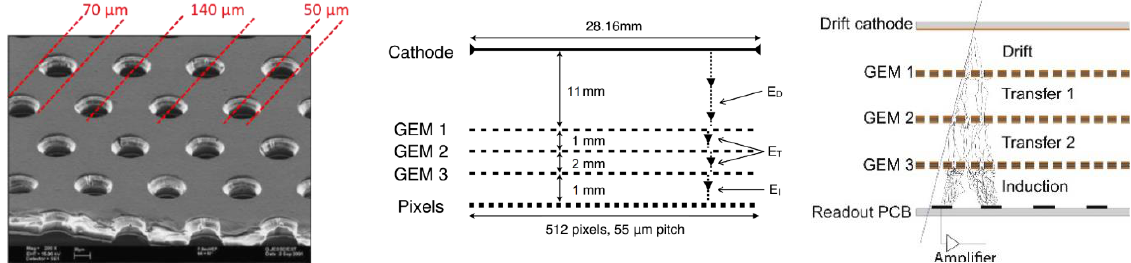
Figure 2. ( Left ) magnified image of a GEM foil. ( Centre ) scheme of a typical triple GEM in the GEMPix detector and the electric transport fields: drift field (ED), transfer fields (ET) and induction field (EI). ( right ) electron multiplication (source: CERN).